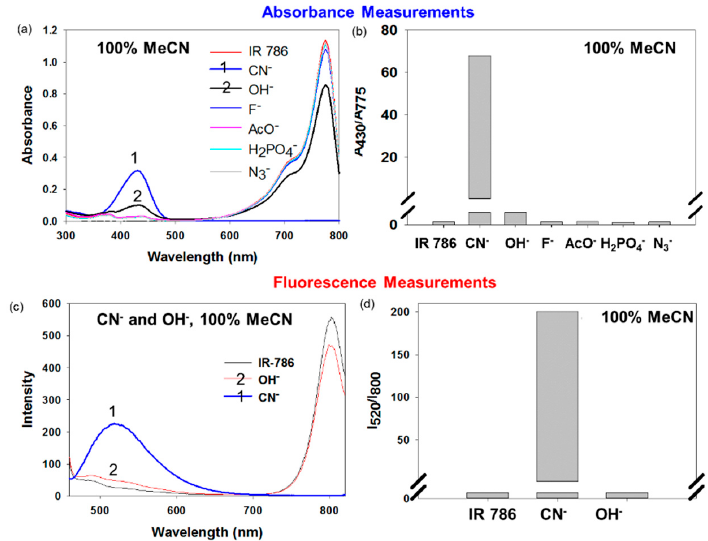
Figure 2. ( a ) UV-vis absorption spectra and ( b ) absorbance ratiometric values (absorbance value at 430 divided by absorbance value at 775 nm) before and after the addition of 1.0 equivalence of various anions to IR-786 (5 μ M) in 100% MeCN and ( c ) emission spectra and ( d ) emission ratiometric values (intensity value at 520 nm divided by intensity value at 800 nm) obtained from (a).